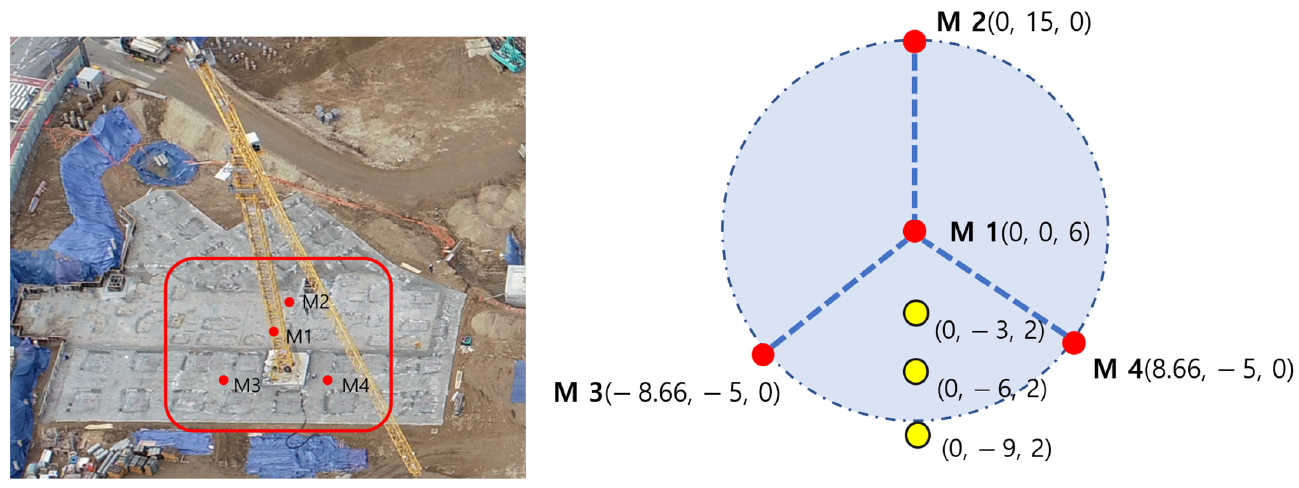
Figure 12. Geometry of the exterior construction site validation test.